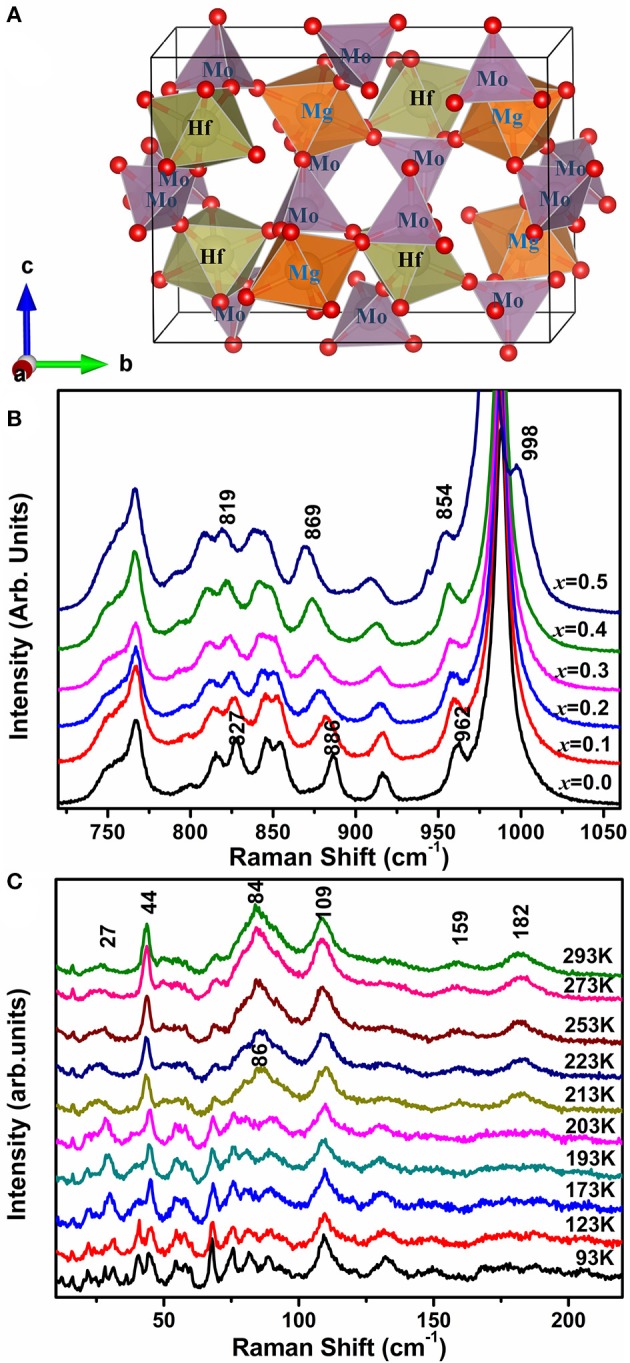
(A) Schematic diagram of HfMgMo3O12 building block (red sphere indicates oxygen atom); (B) Raman spectra of HfMg1−xZnxMo3O12 in the high wavenumber regions; (C) Temperature-dependent Raman spectra of HfMg0.9Zn0.1Mo3O12 in the low wavenumber region.